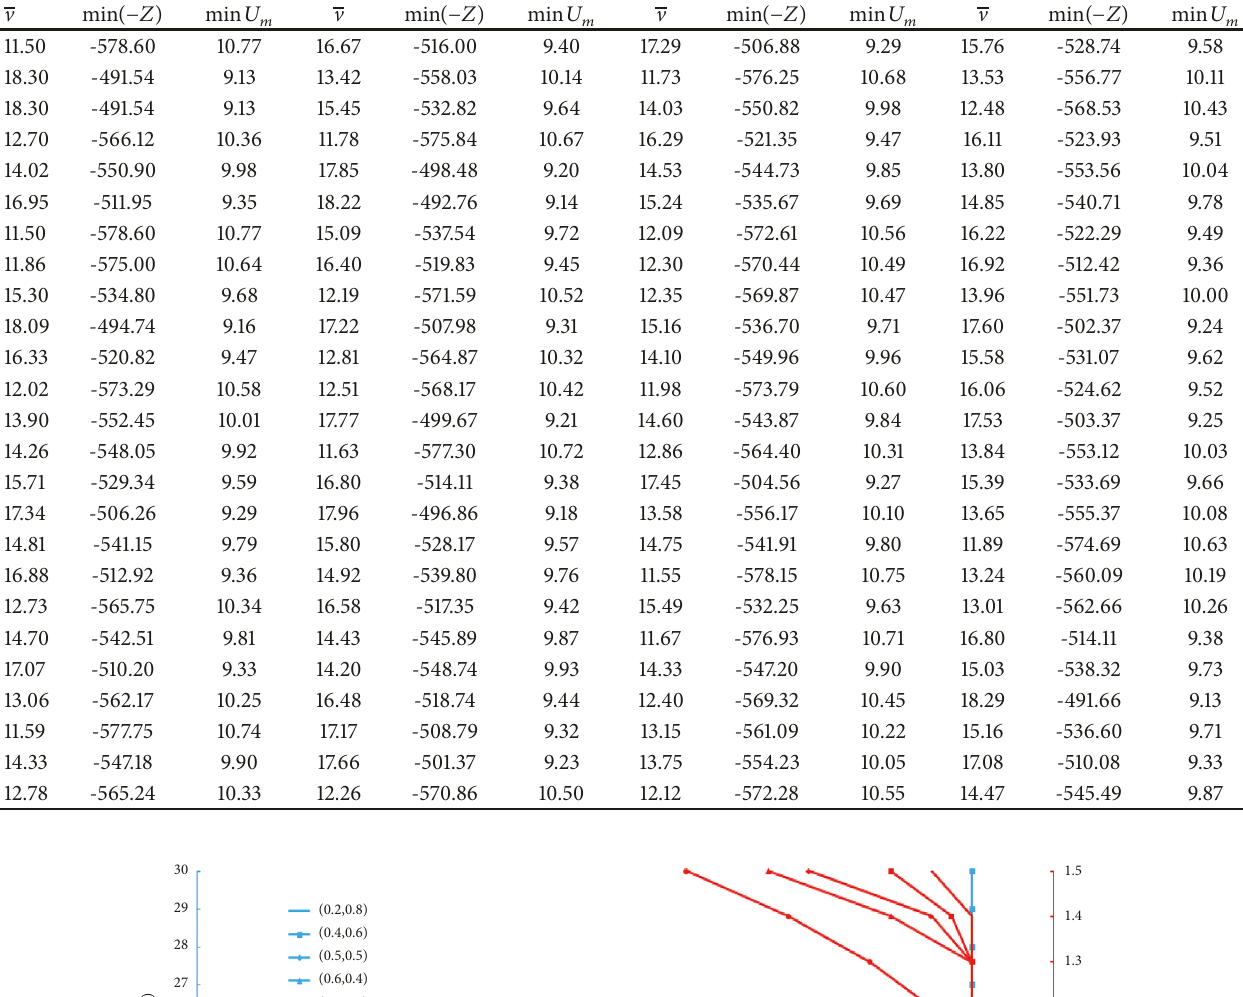
Table 7: The optimization results based on NSGA-II algorithm.